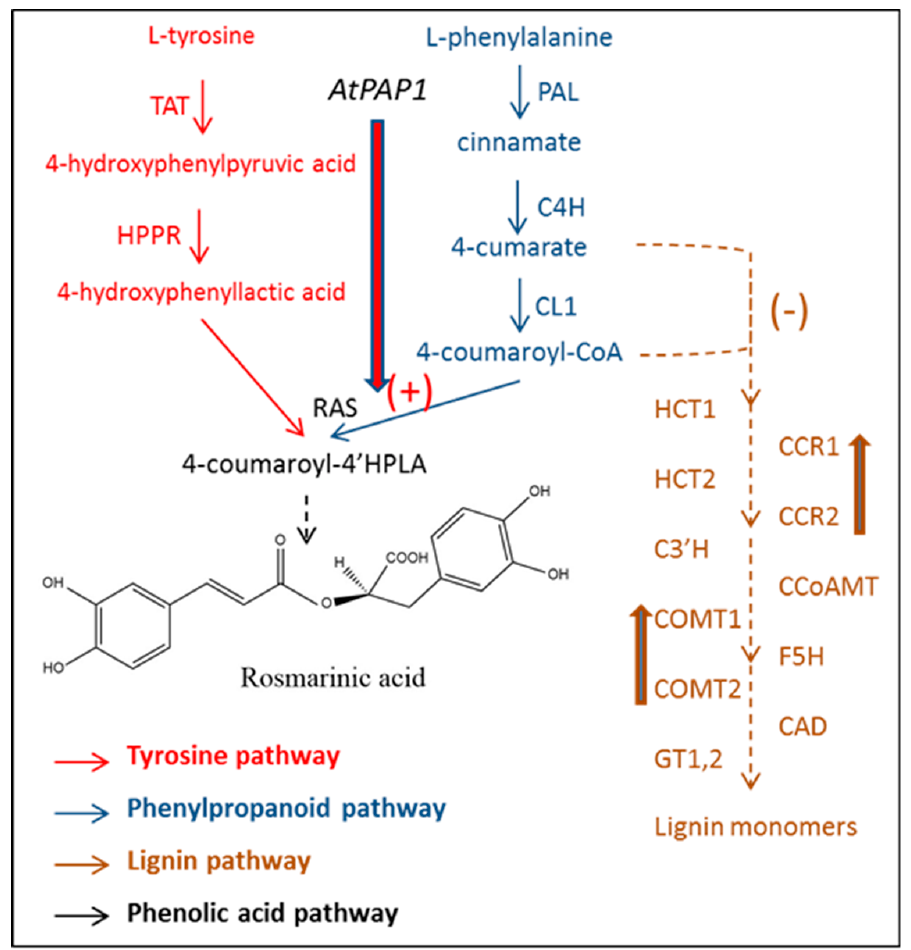
Figure 8. Methodological design based on the biotechnological strategy “increasing income and reducing expenditure” proposed by Zhang et al. [200] for improving RA production. CCR, cinnamoyl-CoA reductase; CCoAMT, caffeoyl-CoA O methyltransferase; C3 ′ H, coumarate 3 ′ - hydroxylase; C4H, cinnamate 4-hydroxylase; 4CL, hydroxycinnamate-CoA ligase; COMT, caffeic acid O-methyltransferase; GT, glycosyl transferase; HCT, hydroxycinnamoyl transferase; HPPR, hydroxyphenylpyruvate reductase; PAL, phenylalanine ammonia lyase; RAS, rosmarinic acid synthase; TAT, tyrosine aminotransferase.